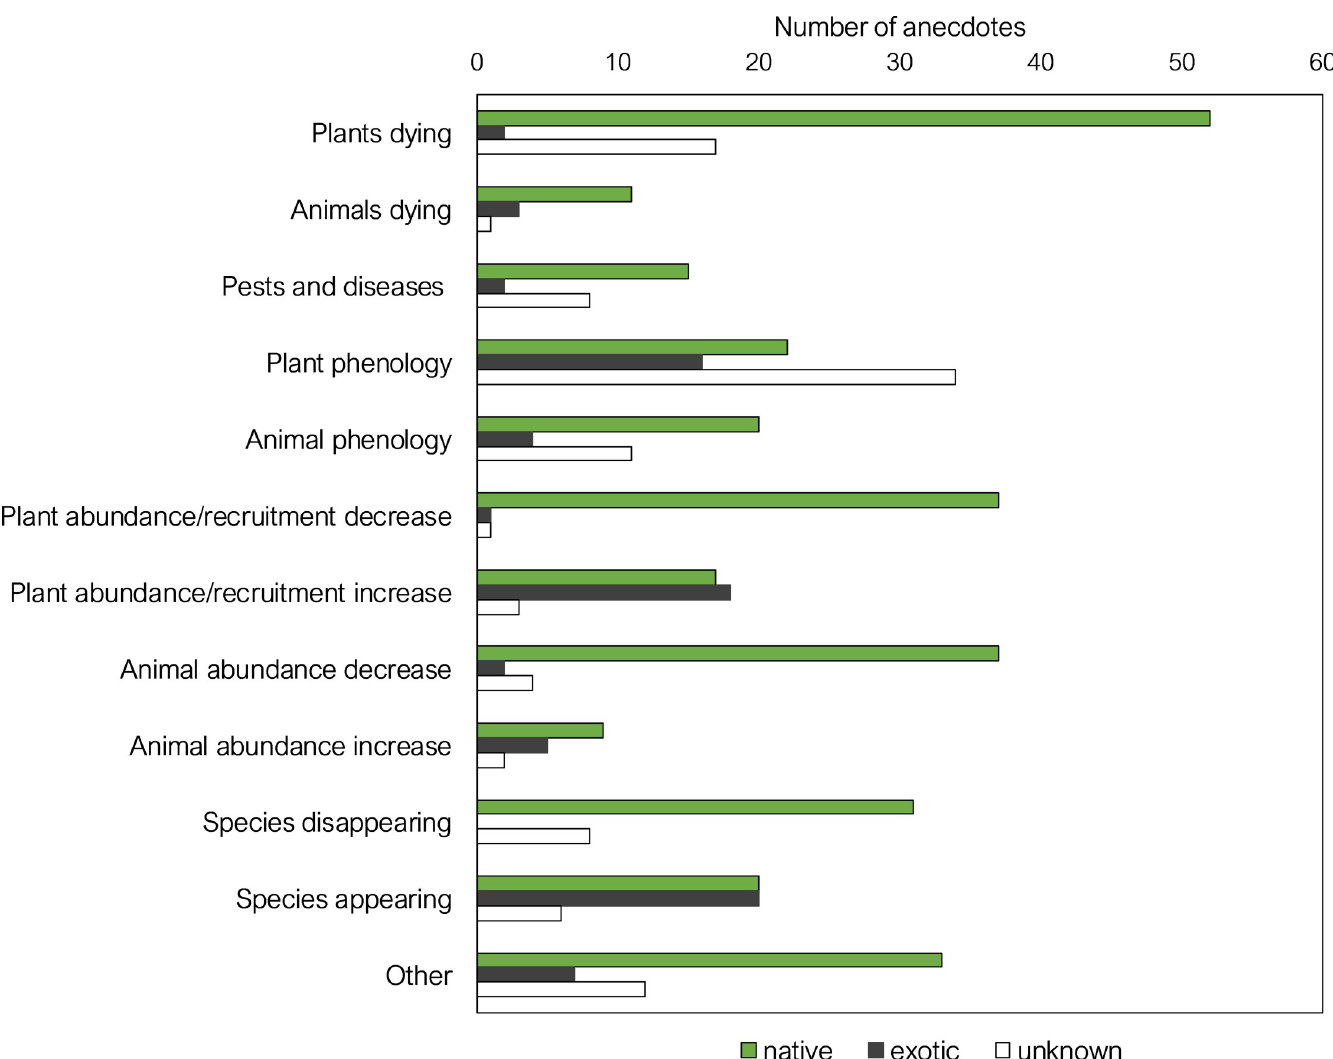
Fig 4. Number of anecdotes reporting climate change impacts on native versus exotic species. Shown against the different primary change classes, with changing plant and animal abundance partitioned to increasing and decreasing abundance. Nearly all cases for pests and diseases involved increases; native and exotic scored for the host